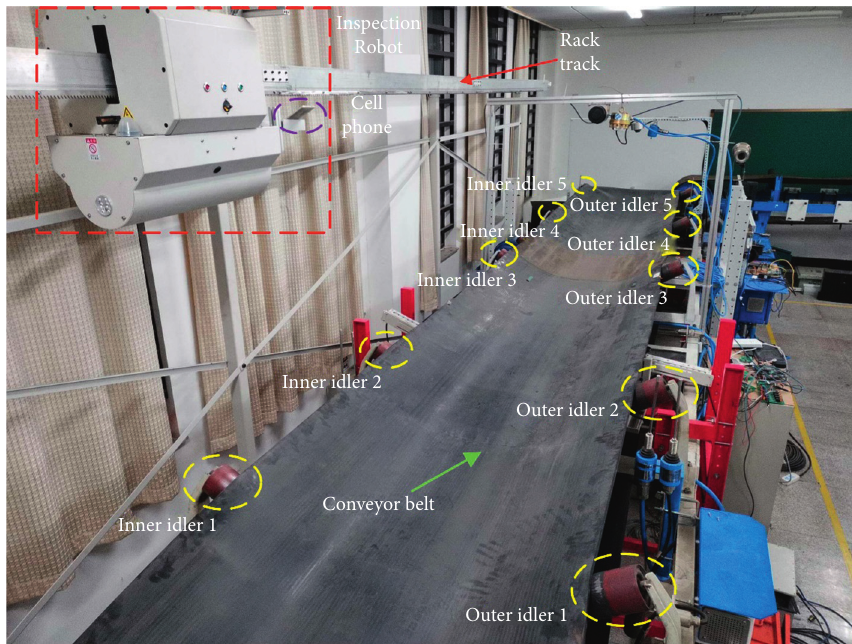
Figure 5: The inspection robot and belt conveyor experimental